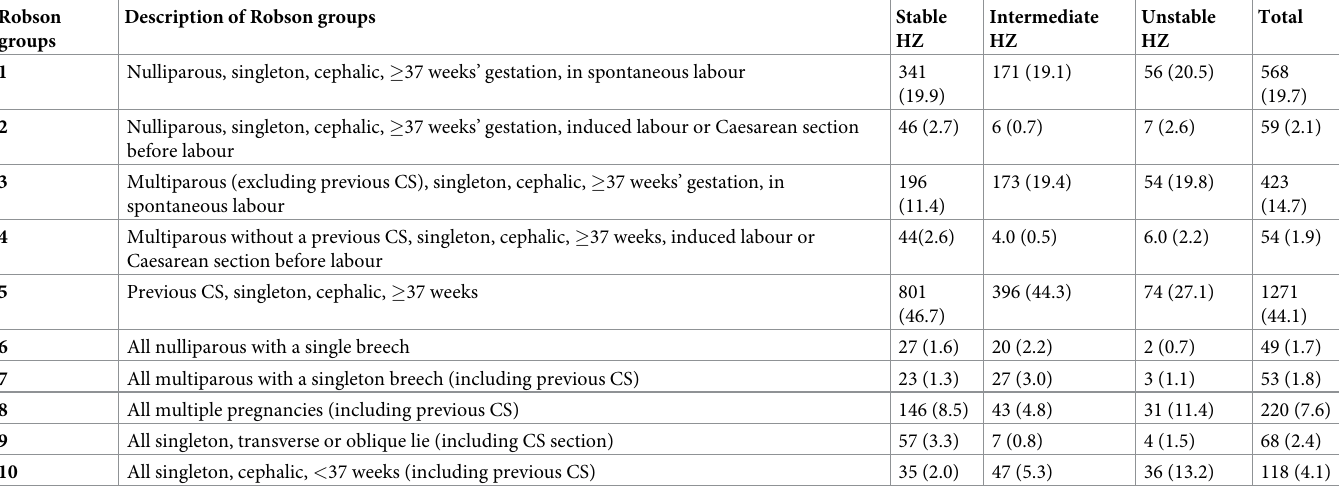
Table 2. Distribution of C-section by conflict location using the Robson